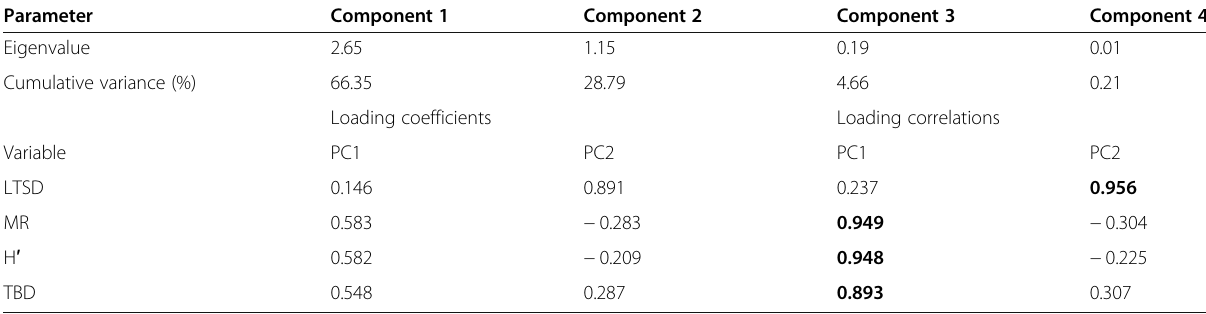
Table 5 Eigenvalues and cumulative variance explained by components along with loading coefficients and correlation of variables with principal